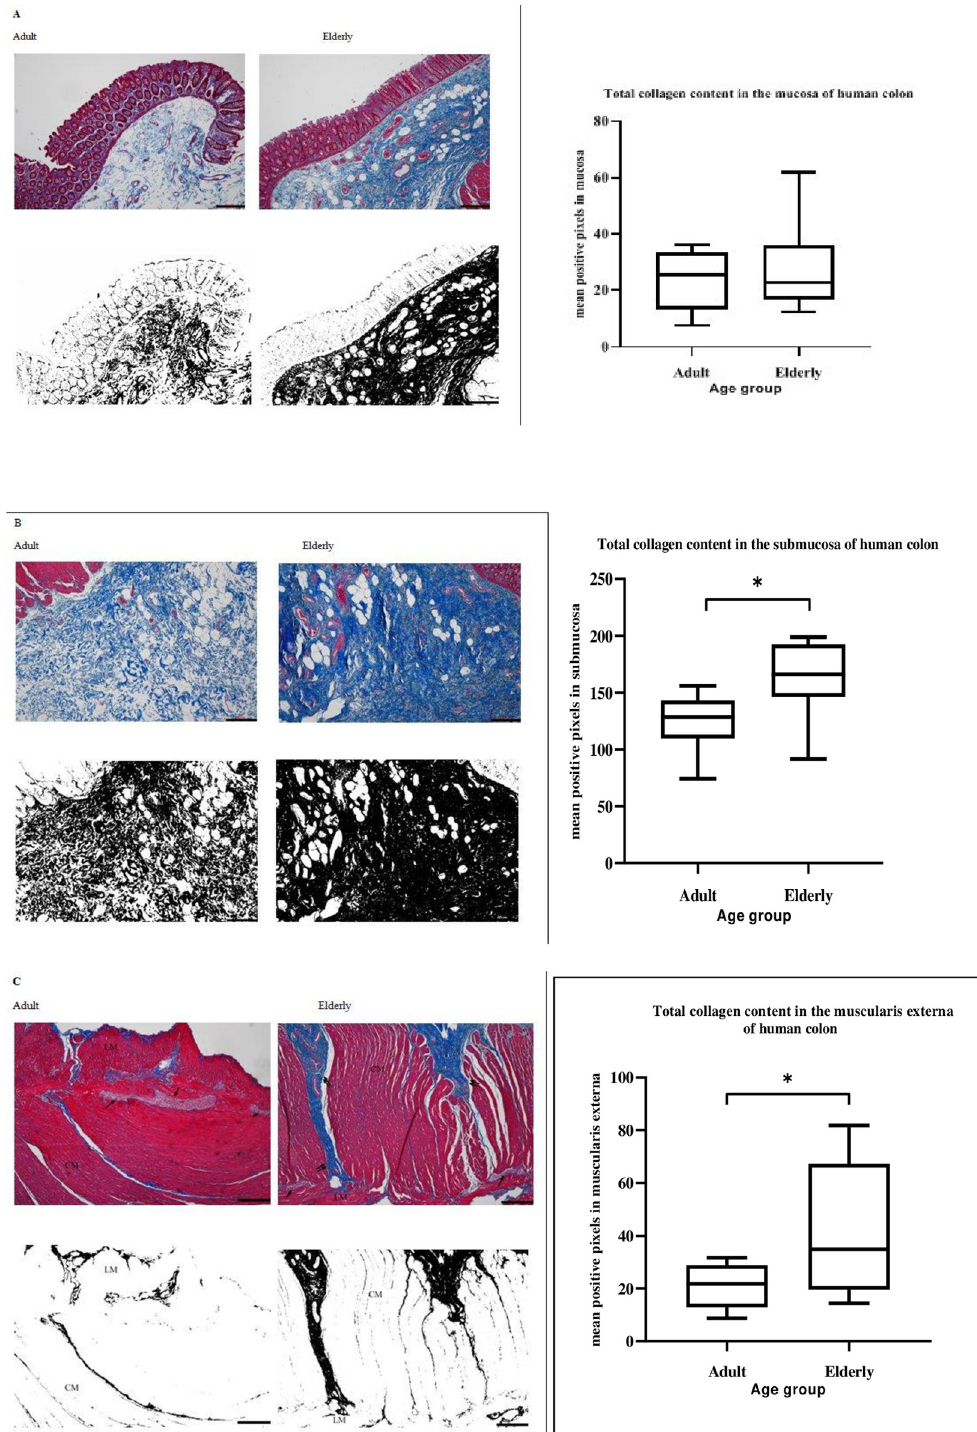
Fig 6. Collagen distribution in the sublayers of human ascending colon. Representative photomicrographs of formalin- fixed paraffin-embedded sections of full-thickness adult and elderly human ascending colon stained with Masson’s trichrome showing the distribution pattern of collagen fibres in ( A ) mucosa, ( B ) submucosa and ( C ) muscularis externa (single arrow: Myenteric plexus; double arrow: Thick collagen fibres; CM and LM: Circular and longitudinal muscle, respectively). Separation of blue colour representing collagen fibres from the background and filtered images converted to